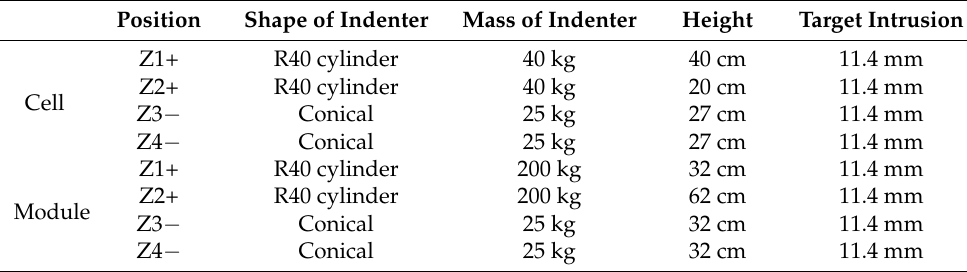
Table 1. Battery cell and Module Test Conditions.